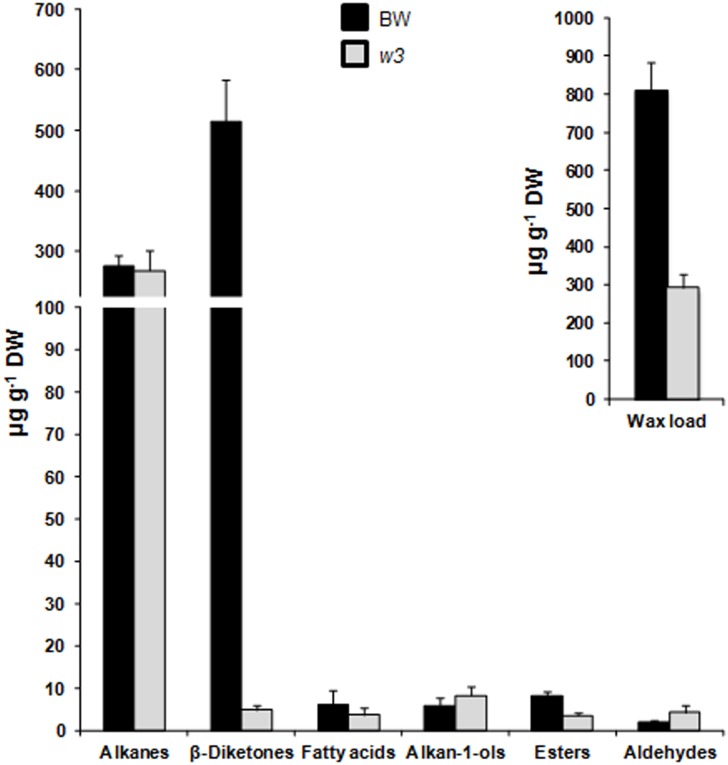
Wax composition of BW and w3 mutant.Total wax load and content of alkanes, β-diketones, primary alcohols (alkan-1-ols), aldehydes, wax esters, and fatty acids of the flag leaf sheaths were measured by GC-MS. The numbers on the y-axes indicate average content expressed as μg per g dried tissue (dry weight, DW). The error bars indicate standard deviation of the mean estimated from five biological replicates.